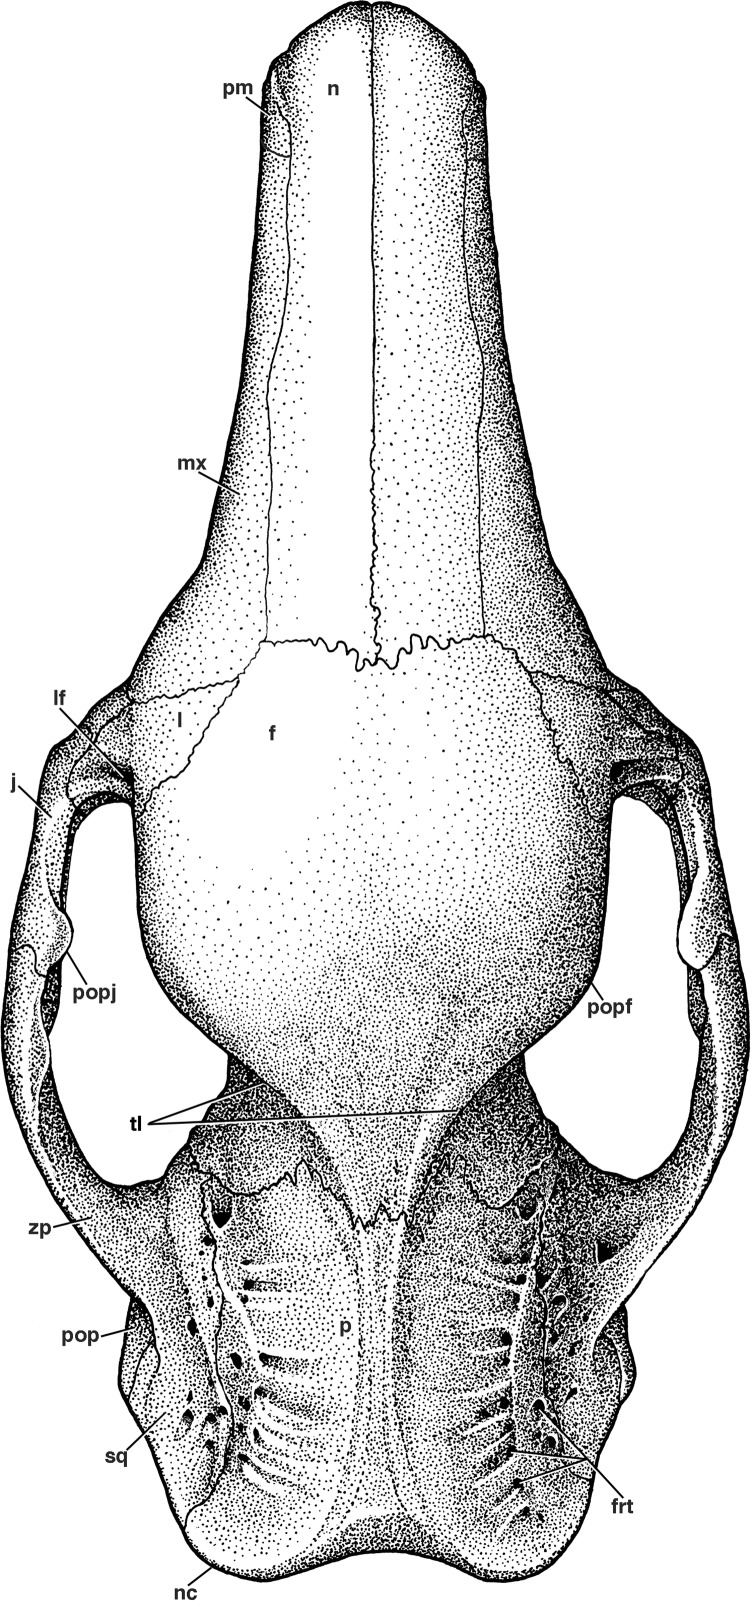
Reconstruction of the skull of Holmesina floridanus in dorsal view.f, frontal; frt, foramina for rami temporalis; j, jugal; l, lacrimal; lf, lacrimal foramen; mx, maxilla; n, nasal; nc, nuchal crest; p, parietal; pm, premaxilla; pop, paroccipital process of petrosal (=mastoid process of Patterson, Segall & Turnbull (1989)); popf, postorbital process of frontal; popj, postorbital process of jugal; sq, squamosal; tl, temporal lines; zp, zygomatic process of squamosal.